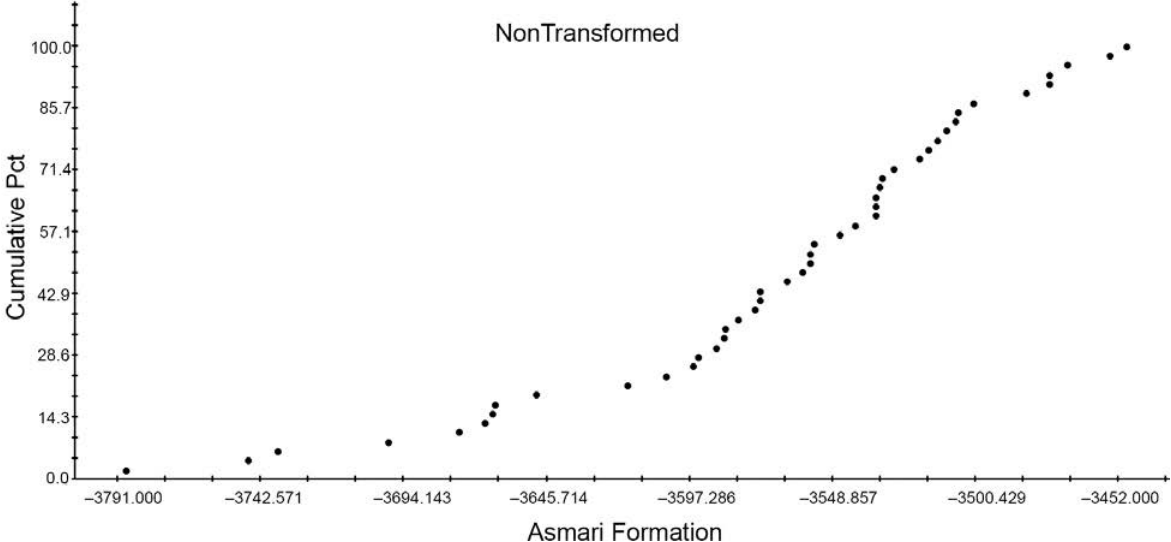
Fig. 3. Cumulative frequency curve of data